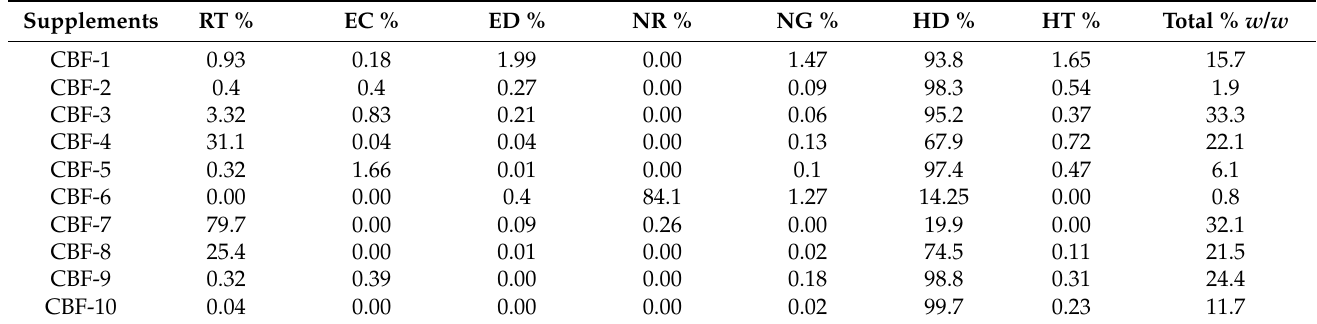
Table 3. Citrus bioflavonoids content of commercial supplements.